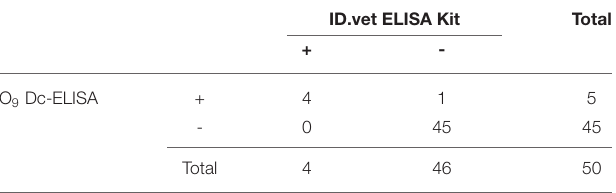
TABLE 3 | Comparison of the results between O 9 Dc-ELISA and ID.vet ELISA